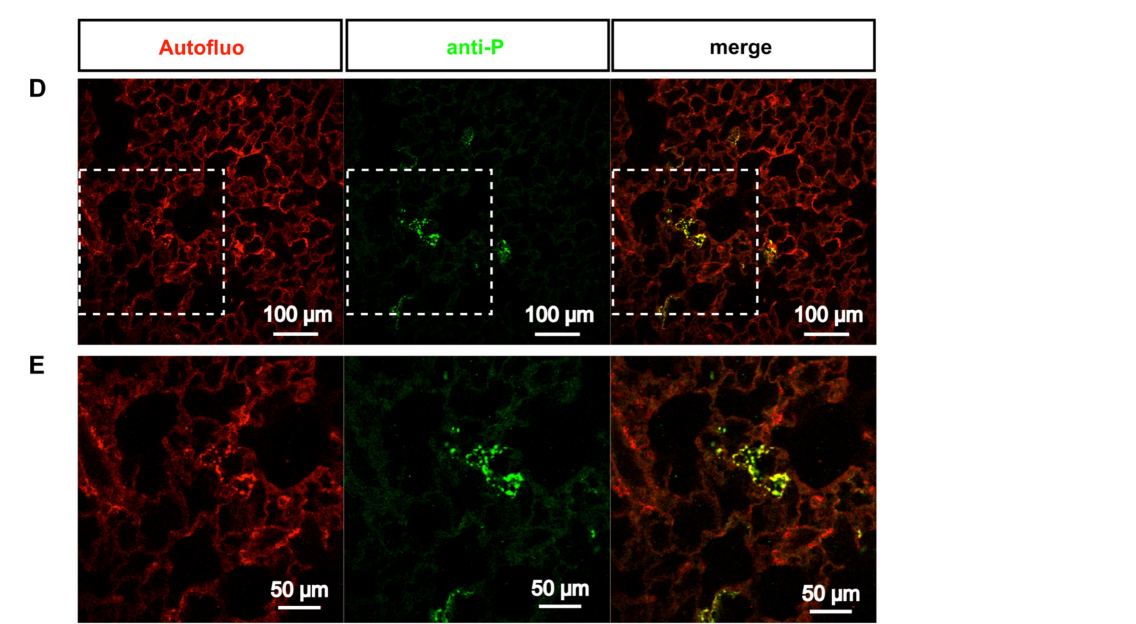
Figure 4. Visualization of RSV inclusion bodies ex vivo . ( A - C ) Biopsies of rHRSV-mCherry infected mouse lung were stained to visualize cell membrane and cytoplasm (DiI, red), nucleus (DAPI, cyan) and RSV inclusion bodies (anti-N antibody, green). After clearing, immunostained biopsies were acquired by confocal microscopy. ( A ) Maximal projection of a 30 µ m z-stack showing inclusion bodies in sparse cells of the parenchyma. ( B ) Representative optical section showing inclusion bodies in the cytoplasm of infected cells. White dotted squares delineate the magnified view presented in ( C ). ( D ) Biopsies of rHRSV-mCherry infected mouse lung were stained with anti-P antibody (green) to visualize RSV inclusion bodies. Autofluorescence (red) was acquired to visualize tissues. Representative optical section. White dotted squares delineate the magnified view presented in ( E